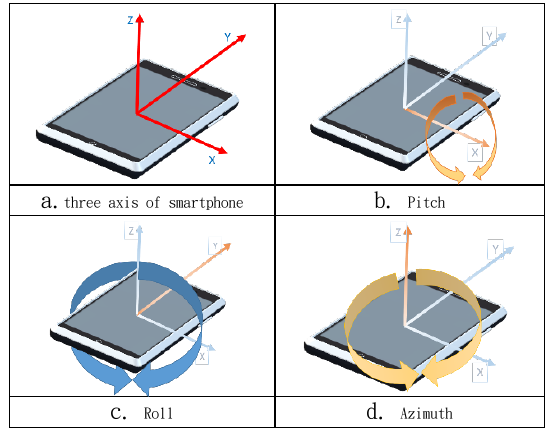
Figure 4. Definition of the angle of